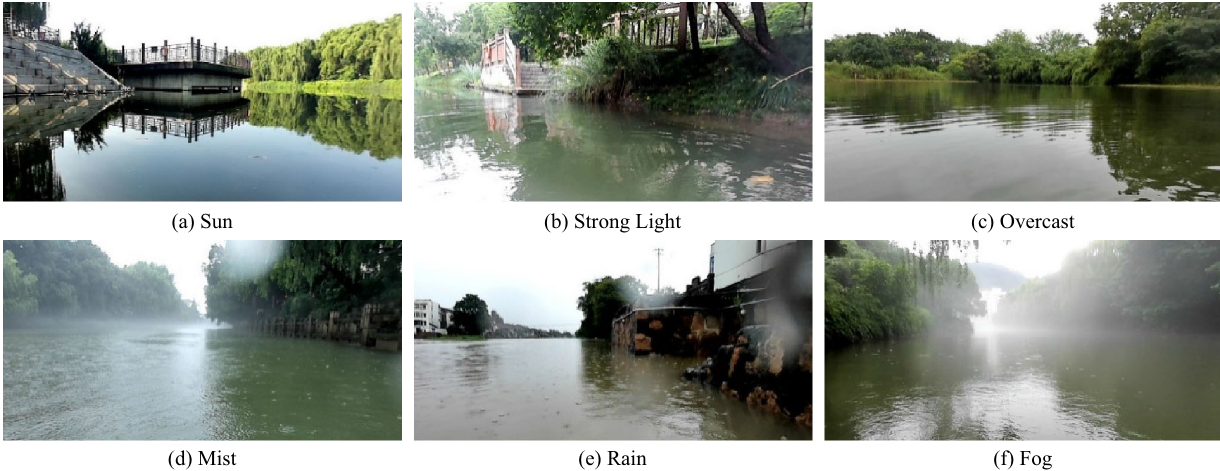
Fig. 10 The images in different